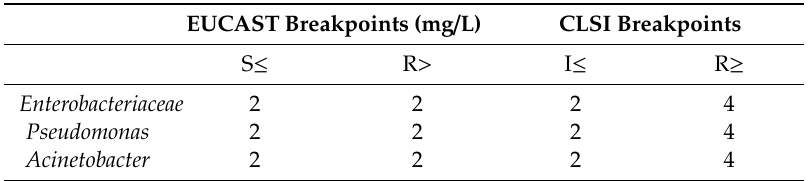
Table 1. Minimum inhibitory concentration (MIC) breakpoints of colistin sensitivity according to the European Committee on Antimicrobial Susceptibility Testing (EUCAST) and of colistin / polymyxin B sensitivity according to Clinical Laboratory and Standards Institute